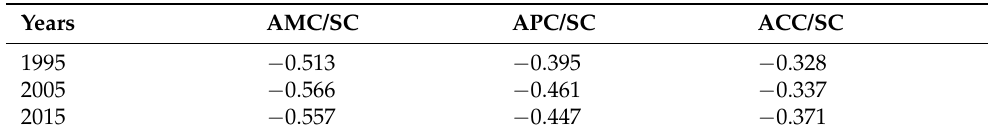
Table 4. Global Moran’s I of bivariate spatial autocorrelationship between traffic accessibility to cities at different administrative levels and soil conservation from 1995 to